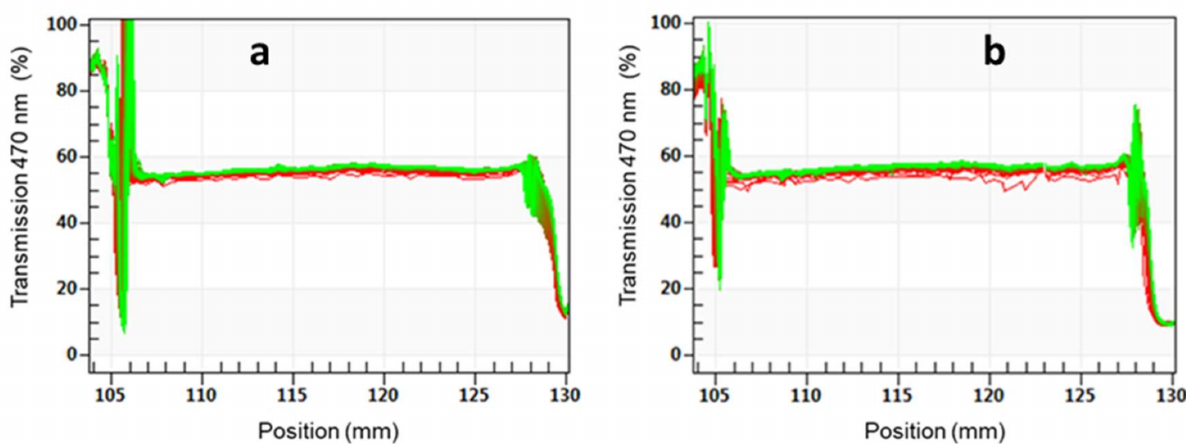
Figure 17. Transmission profiles of 3294IPDI-3 sample subjected to 2000 × g and 40 ◦ C centrifuge tests using a path length of 2 mm. ( a ) Fresh sample and ( b ) sample after one year of storage.